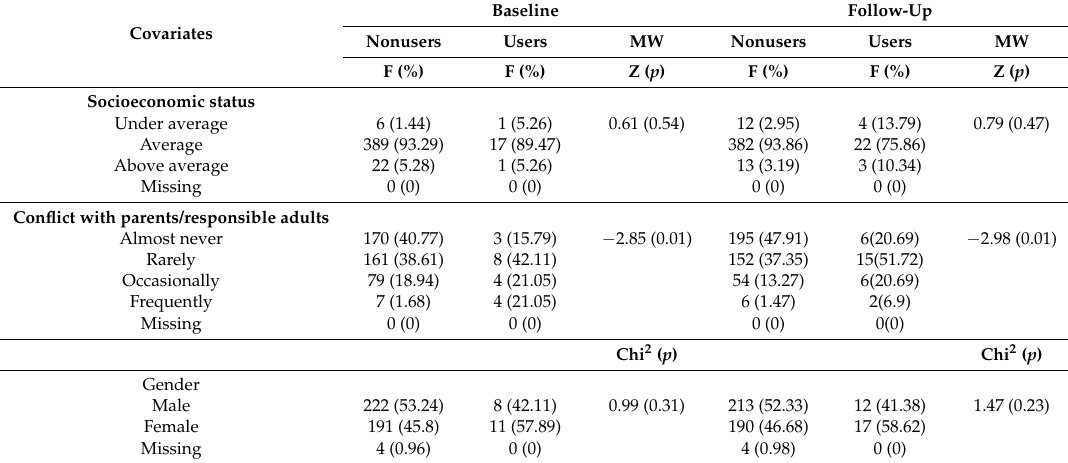
Table 2. Baseline and follow-up results (F—frequency, %—percentage) for socioeconomic status, gender, and parental conflict (covariates) with differences on a basis of consumption of illicit drugs (MW—Mann Whitney Z value, Chi square test—Chi 2 , p —level of significance). Baseline Follow-Up Covariates Nonusers Users MW